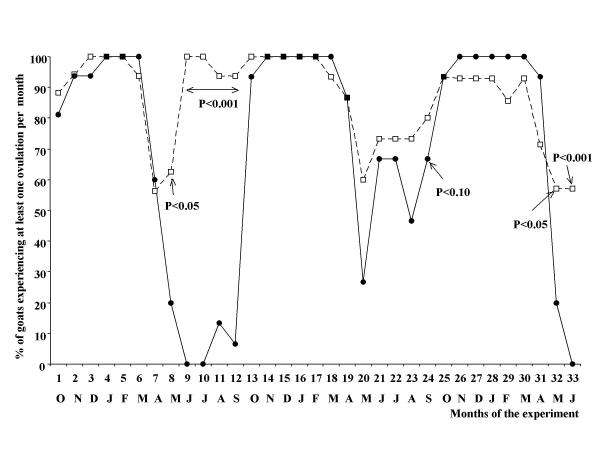
Ovulatory activity in Creole goats maintained under two different photoperiodic conditions. Two groups of Creole female goats were maintained in light-proof rooms and subjected to either simulated temperate photoperiodic conditions (TE solid line closed circles, 16 goats, 8 to 16 hours of light per day from winter to summer solstice), or simulated tropical photoperiodic conditions (TR dashed line open squares, 17 goats, 11 to 13 hours of light per day from winter to summer solstice) for 33 months. Ovulatory activity was assessed by twice-weekly (first 25 months), then once-weekly (last 8 months) determinations of plasma progesterone by radioimmunoassay. Results are expressed as the percentage of female goats experiencing at least one ovulation per month. Significant differences between groups are indicated.